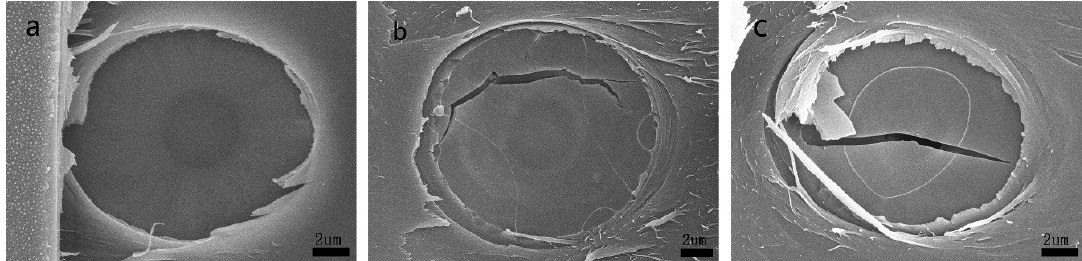
Figure 2. SEM micrographs of bordered pit membranes under different MW intensities: ( a ) Control, ( b )low ‐ intensity, ( c )high ‐ intensity.